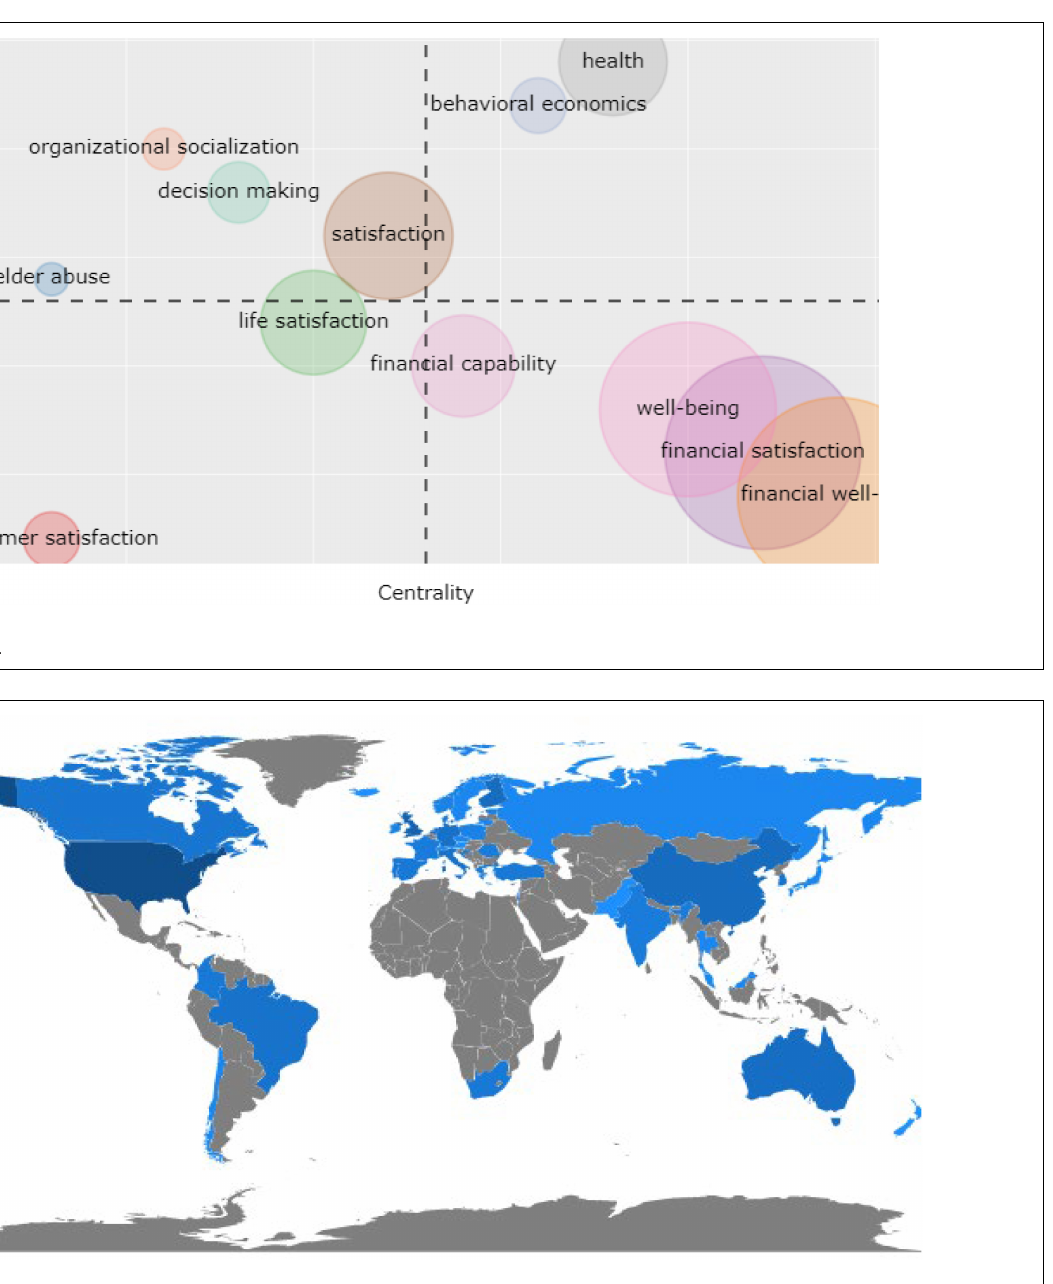
FIGURE 7 | Country